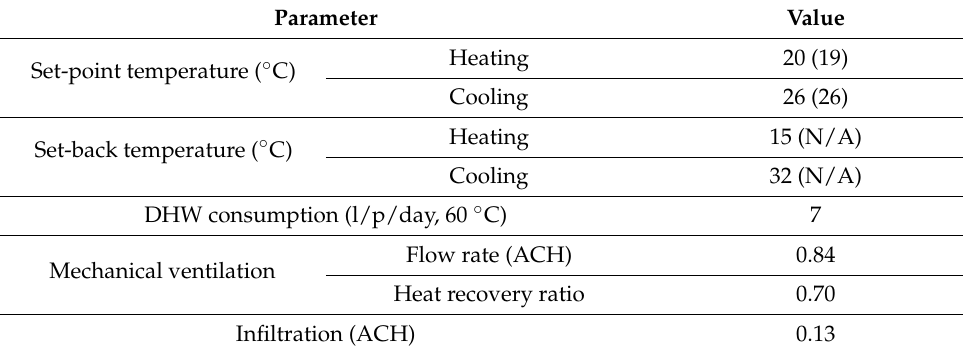
Table 2. Office building simulation parameters (server room values shown in parentheses). Parameter Value